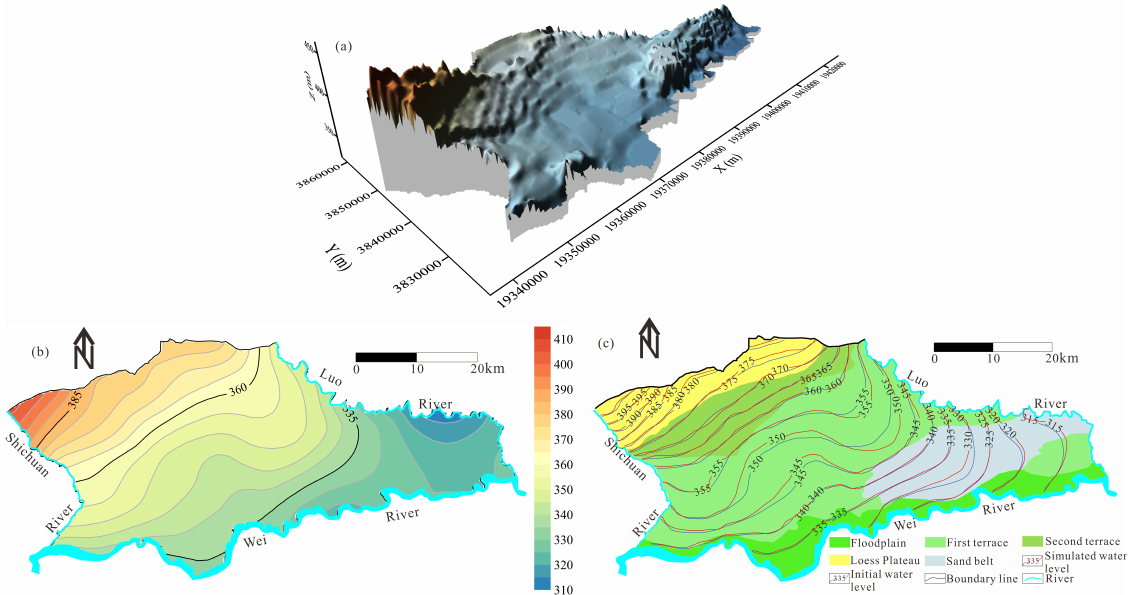
Figure 4. ( a ) Digital elevation model of ground surface in the simulation area; ( b ) The initial head diagram of the study area; ( c ) Comparison chart between the model running results and actual measured water level above mean sea